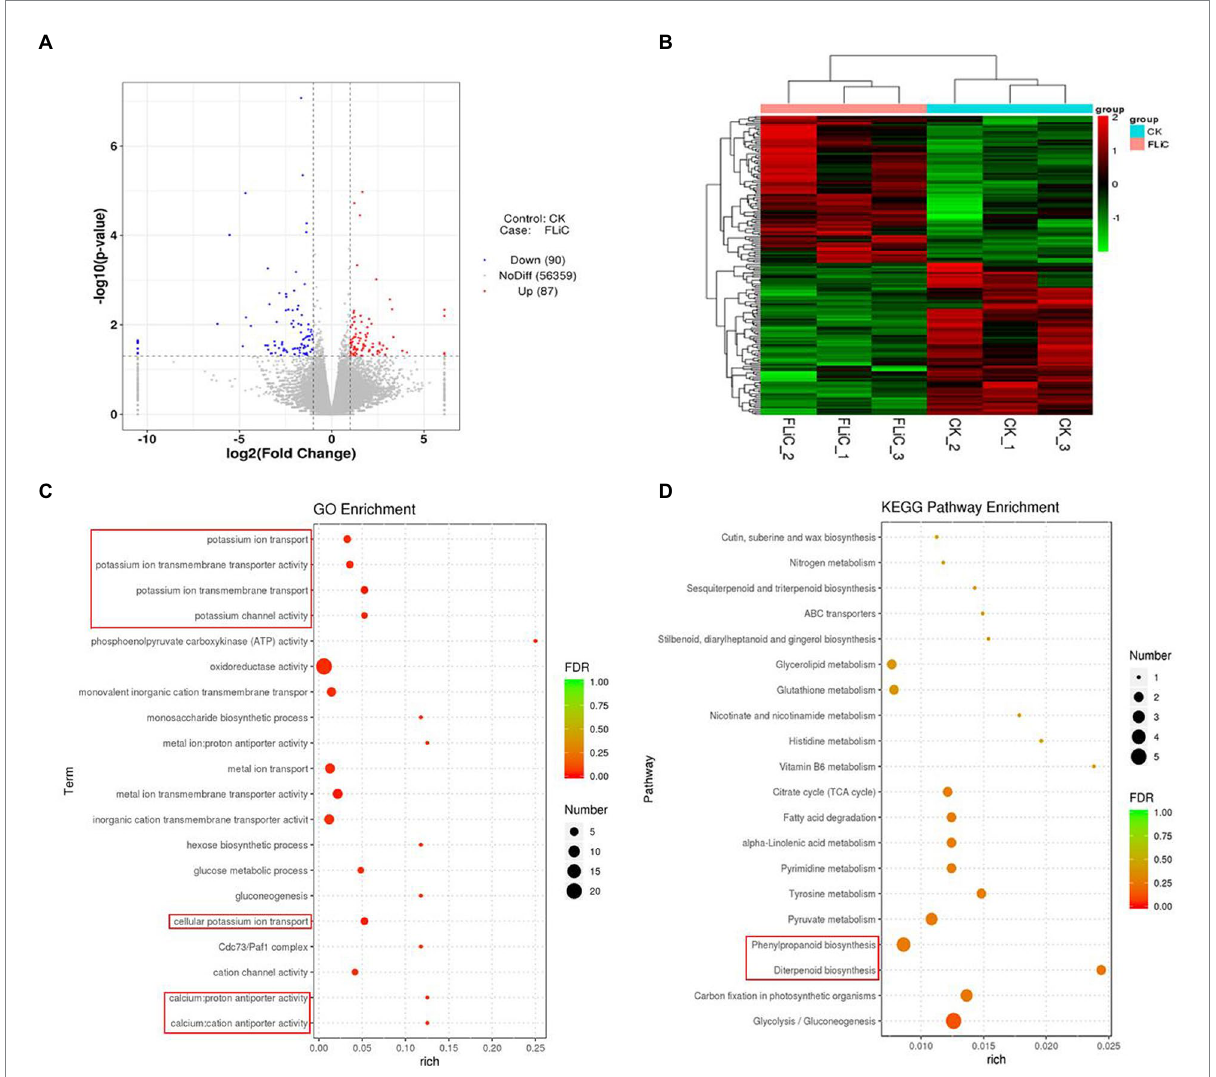
FIGURE 6 Pathways in which the DEGs are significantly enriched according to the transcriptomic data. (A) Volcano plot of DEGs. (B) DEG cluster analysis. (C) Bubble chart of the top 20 metabolic pathways enriched in GO terms. (D) Bubble chart of the top 20 metabolic pathways enriched in KEGG